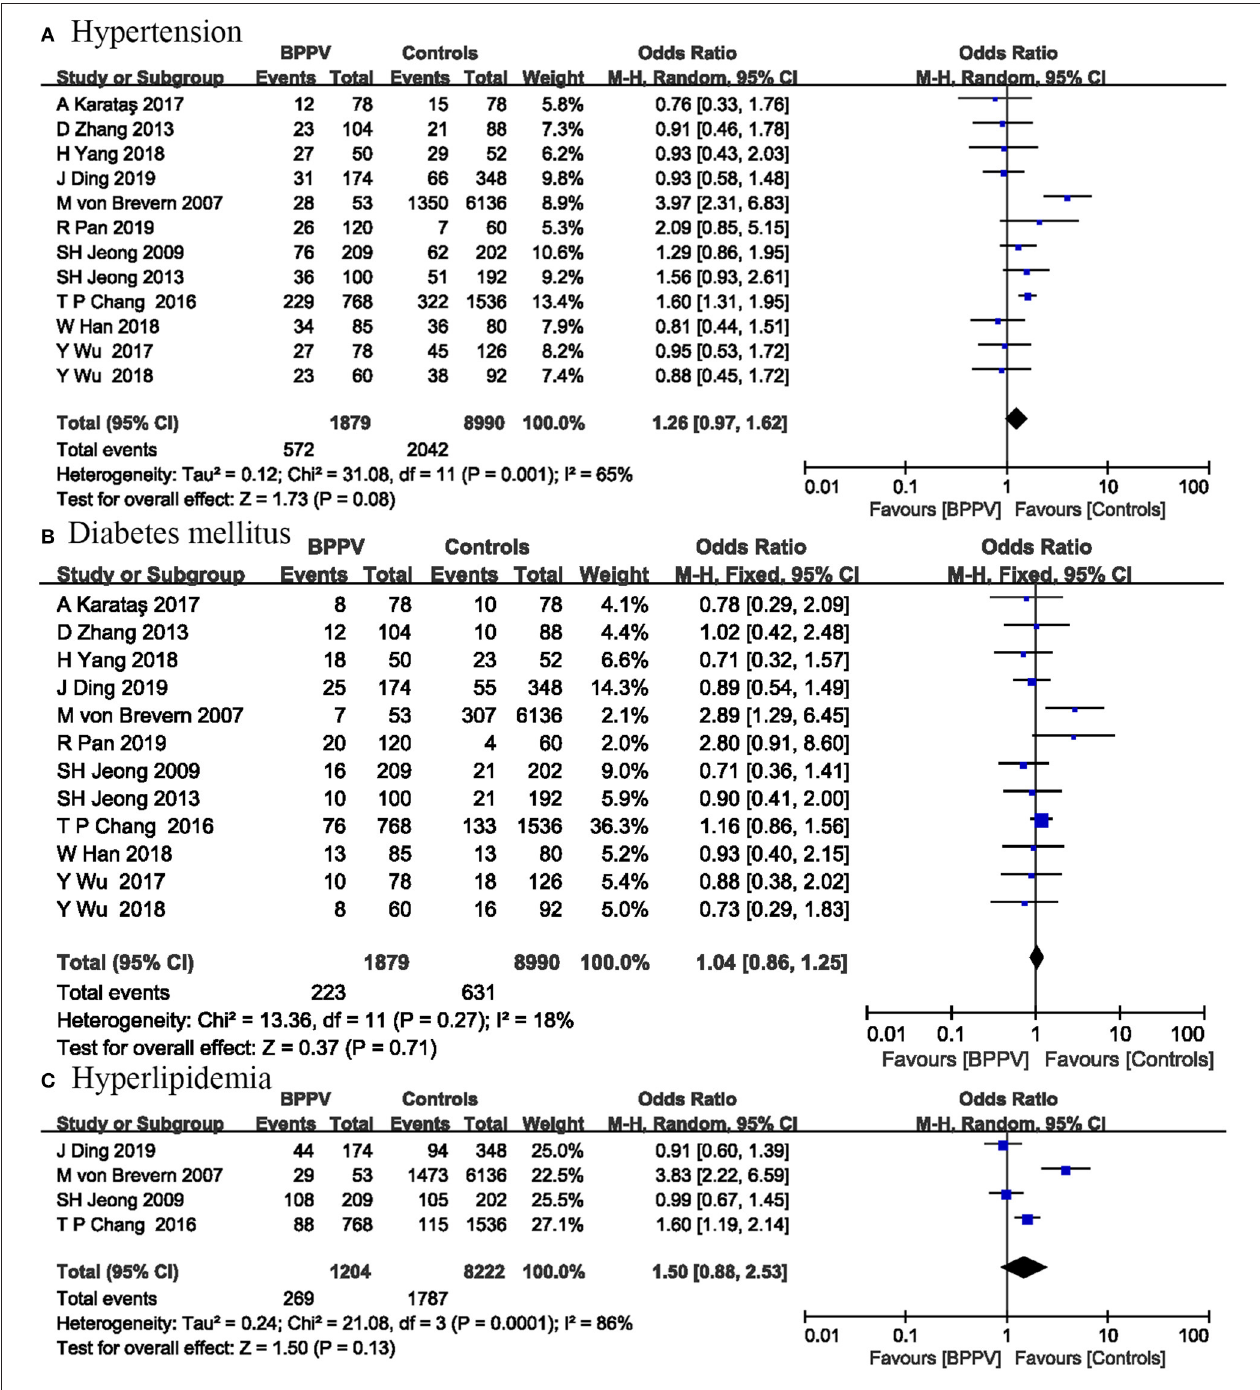
FIGURE 3 | Forest plot of hypertension (A) , diabetes mellitus (B) , and hyperlipidemia (C) .